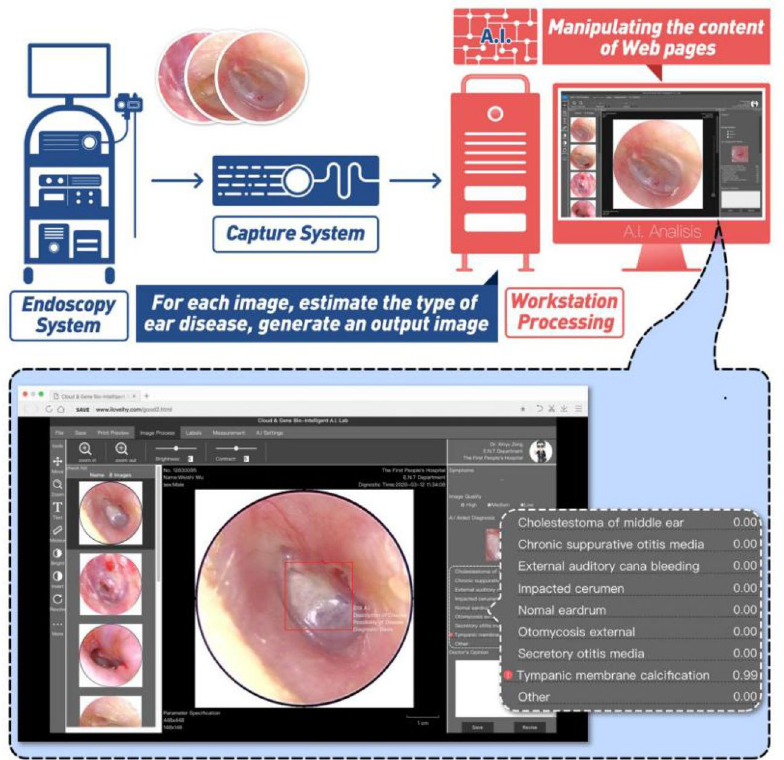
Figure 9. A schematic diagram of the real-time automatic identification system for ear diseases and the system web page of the system. The red border is drawn manually by the doctor.